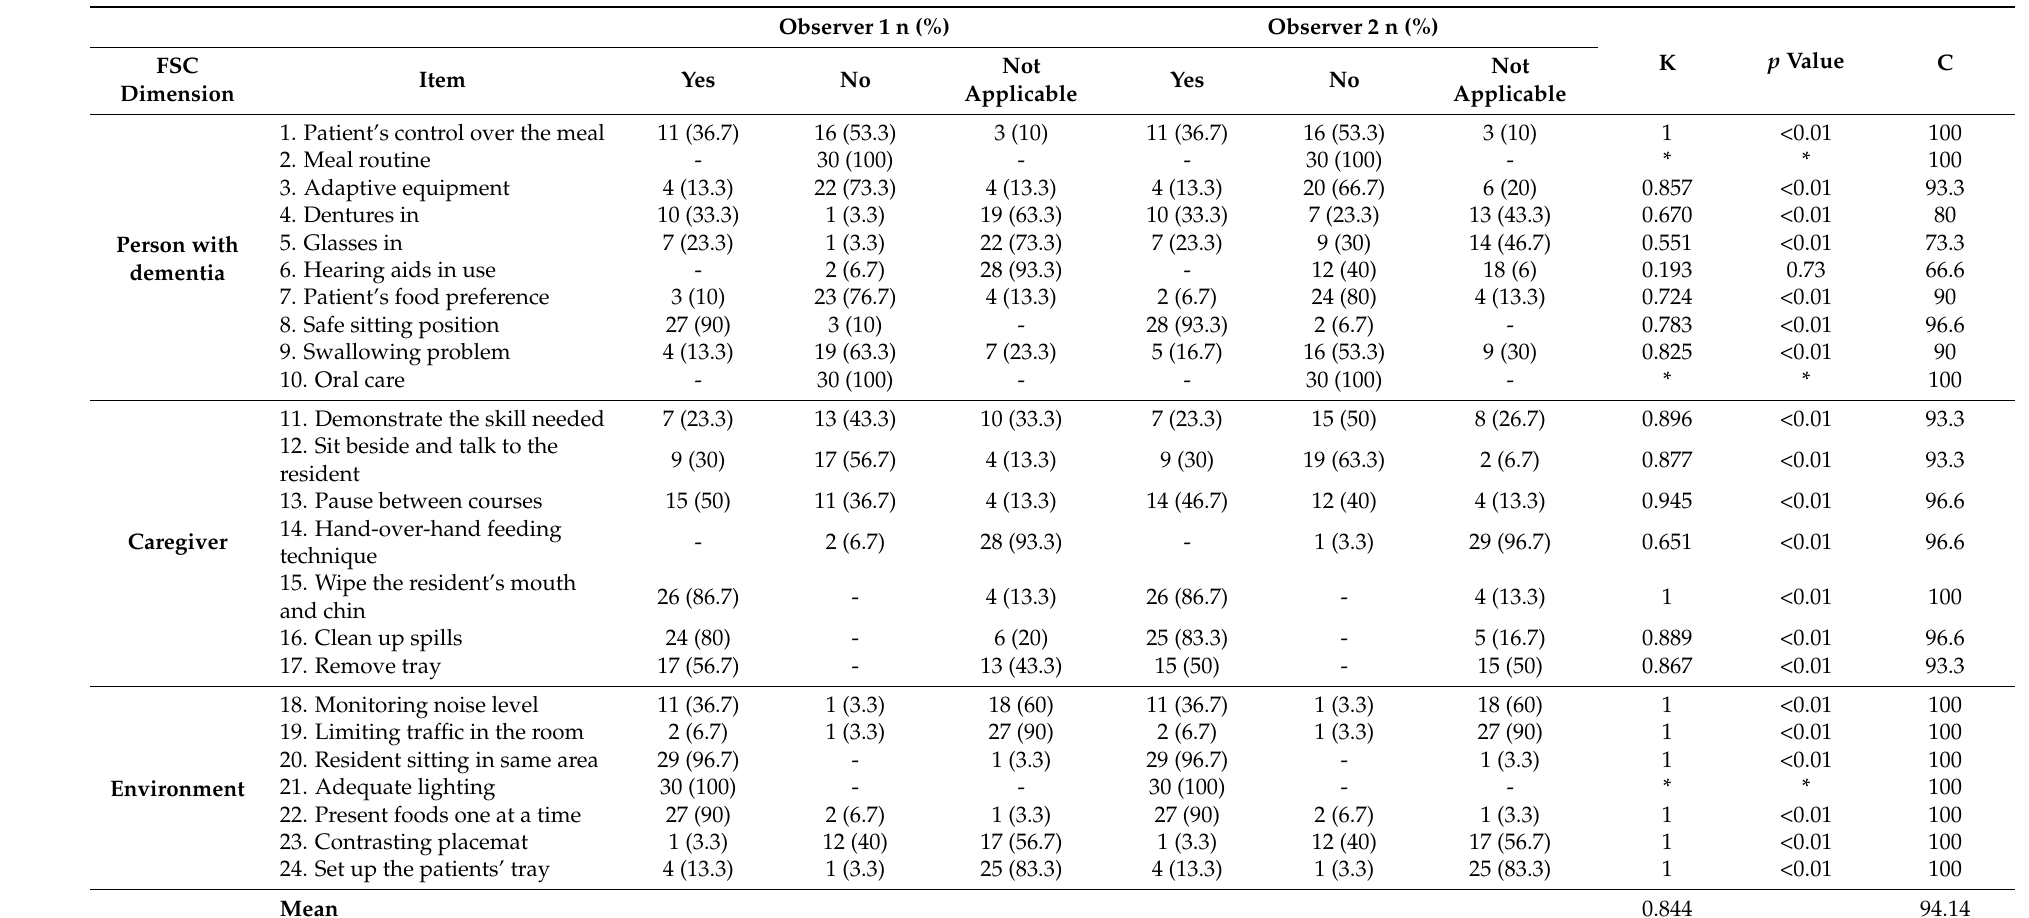
Table 3. FSC-PT interobserver reliability (n =